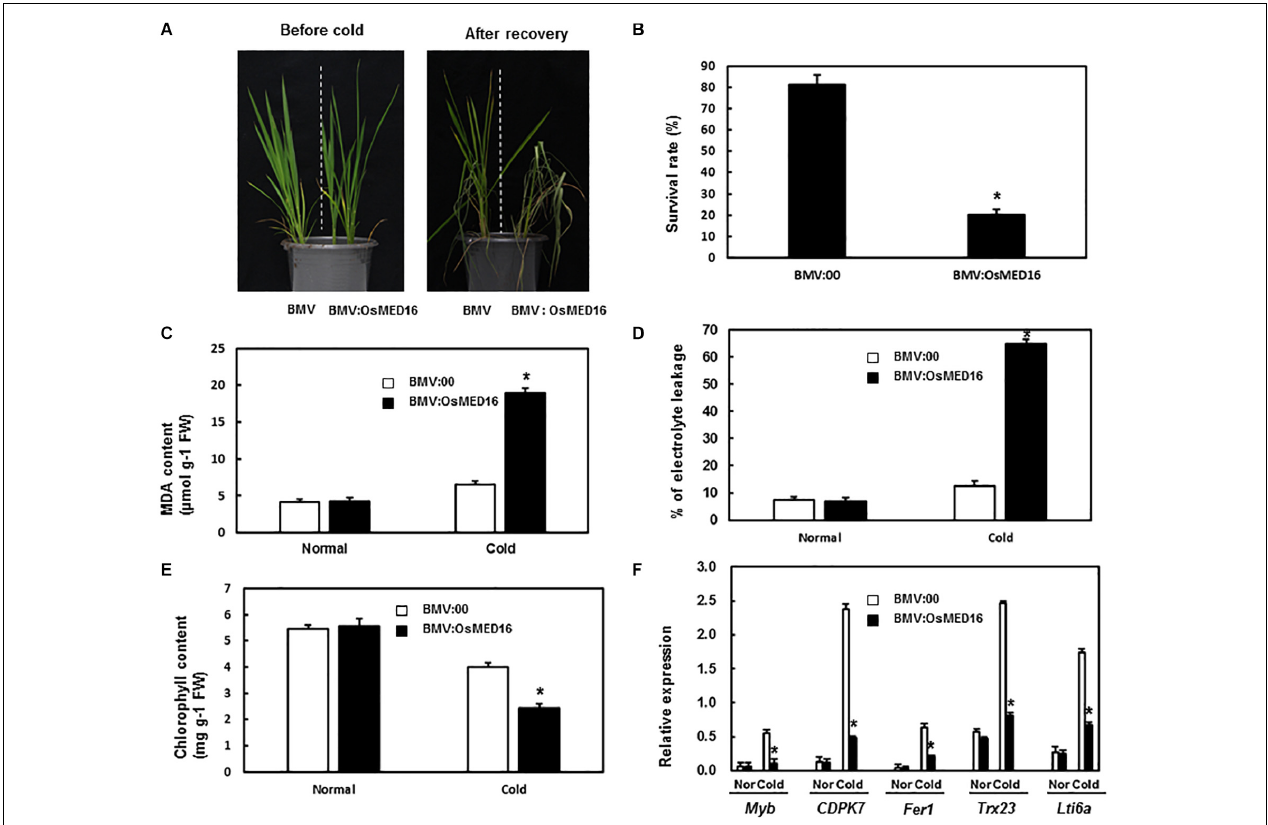
FIGURE 9 | BMV:OsMED16-infiltrated plants showed decreased tolerance to cold stress when compared with BMV:00-infiltrated plants. (A) The phenotype of BMV:OsMED16- and BMV:00-infiltrated plants under cold stress. (B) The survival rate of BMV:OsMED16- and BMV:00-infiltrated plants after cold stress. (C) The MDA content in BMV:OsMED16- and BMV:00-infiltrated plants with and without cold stress. (D) The relative electrolyte leakage in BMV:OsMED16- and BMV:00-infiltrated plants with and without cold stress. (E) The chlorophyll content in BMV:OsMED16- and BMV:00-infiltrated plants with and without cold stress. (F) The expression of cold-responsive genes in BMV:OsMED16- and BMV:00-infiltrated plants before and after cold stress. *Above the columns indicate significant differences at p < 0.05 between the silencing plants and the